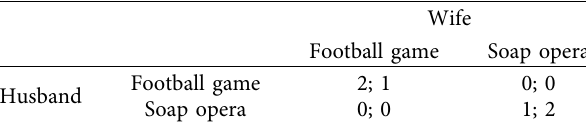
Table 3: Gender war game matrix.